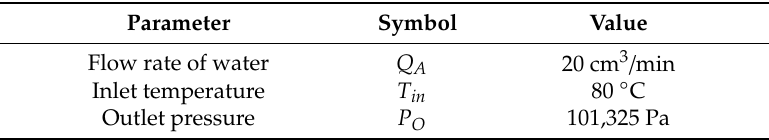
Table 4. Initial and boundary conditions of the PEMWE operation.